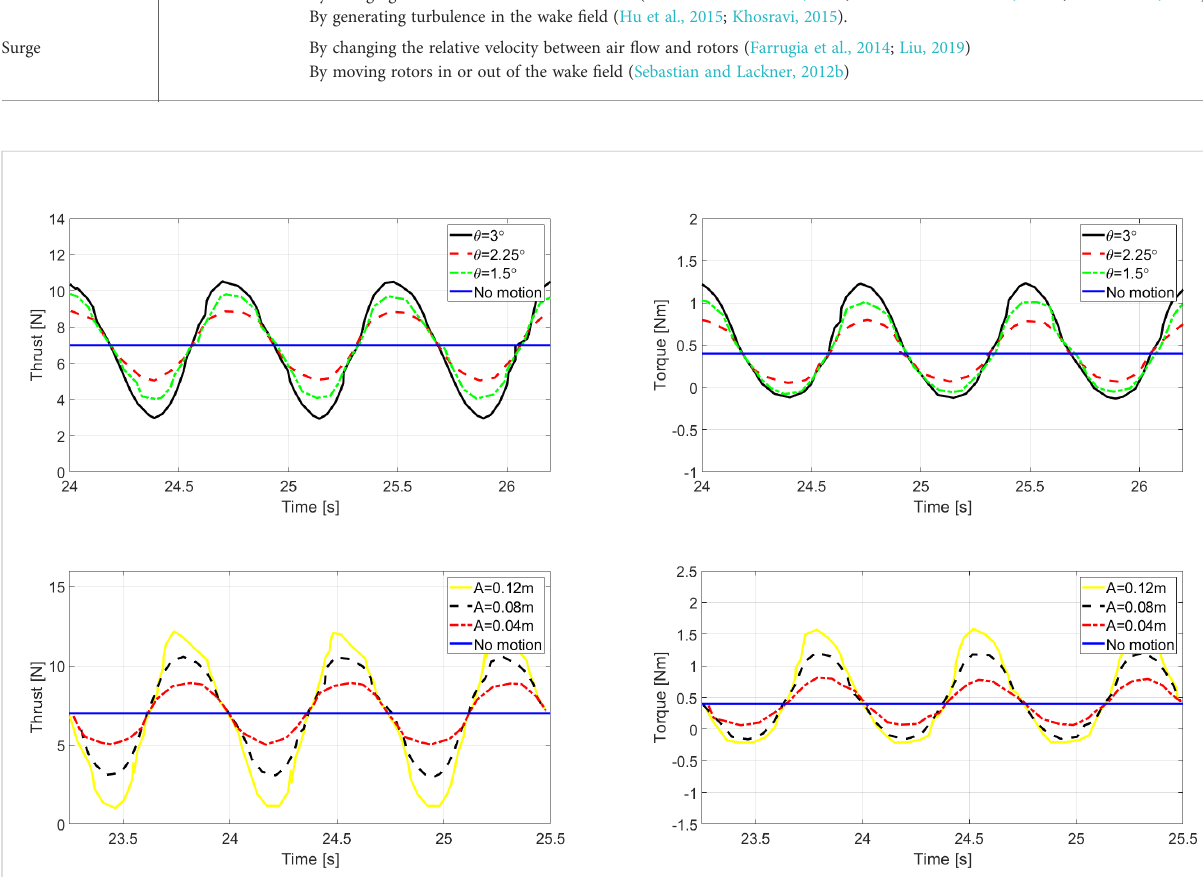
FIGURE 11 Comparison of the thrust and torque among different pitch motion (up) and surge motion (down) (Fang et al., 2020; Fang et al., 2021).